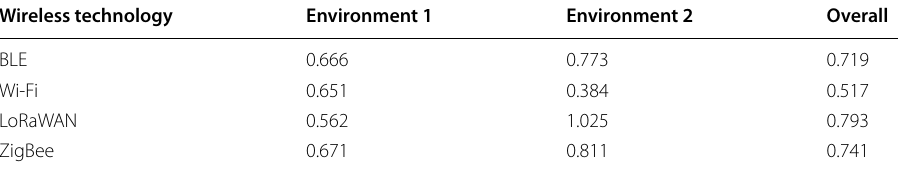
Table 6 Average position error (m) Wireless